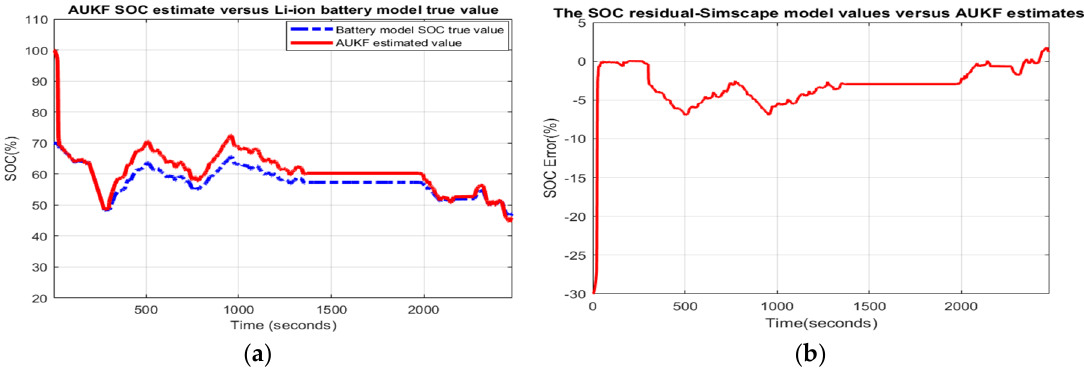
Figure 8. Robustness to simultaneous changes, SOCini = 1, Qnom = 4.2 Ah (ageing effects); ( a ) AUKF SOC value versus battery model true value; ( b ) SOC residual.